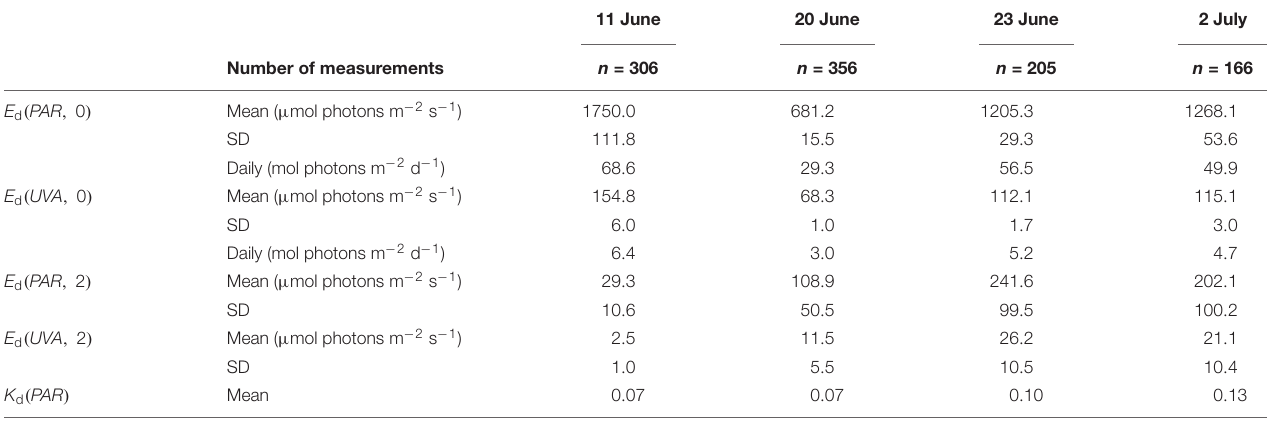
TABLE 1 | Mean and standard deviation (SD) of incoming UVR and PAR at the sea ice surface, E d (0) , and at 2 m water depth, E d (2) , the daily incident UVR and PAR, and the mean vertical diffuse attenuation coefficient, K d (PAR) , for four days in